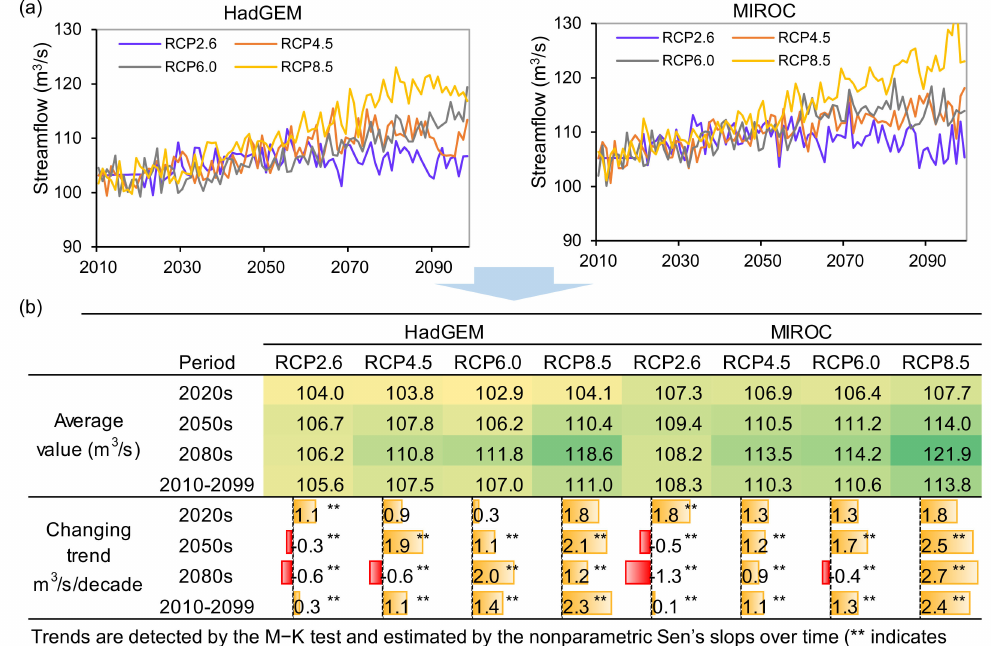
Figure 6. Projected annual streamflow [( a ) time series of streamflow during the period 2010–2099 and ( b ) the associated average values and changing trends by Mann–Kendall